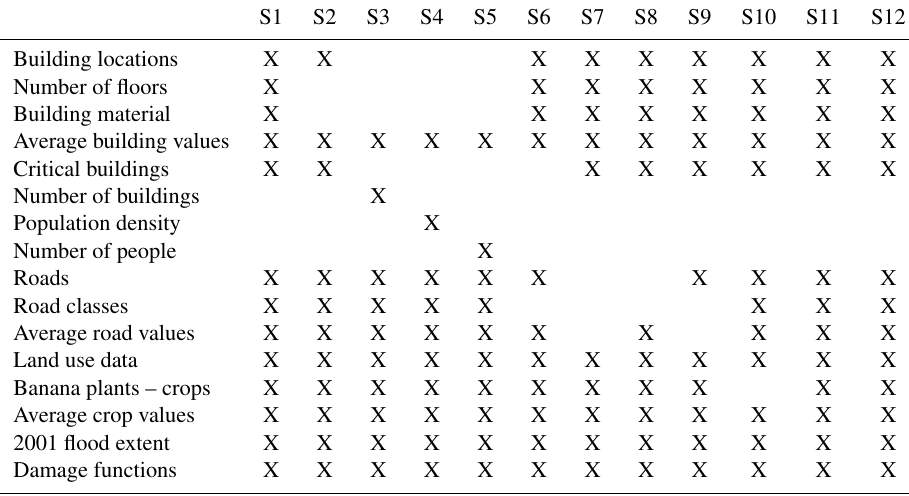
Table 3. Overview of the input data used per scenario.